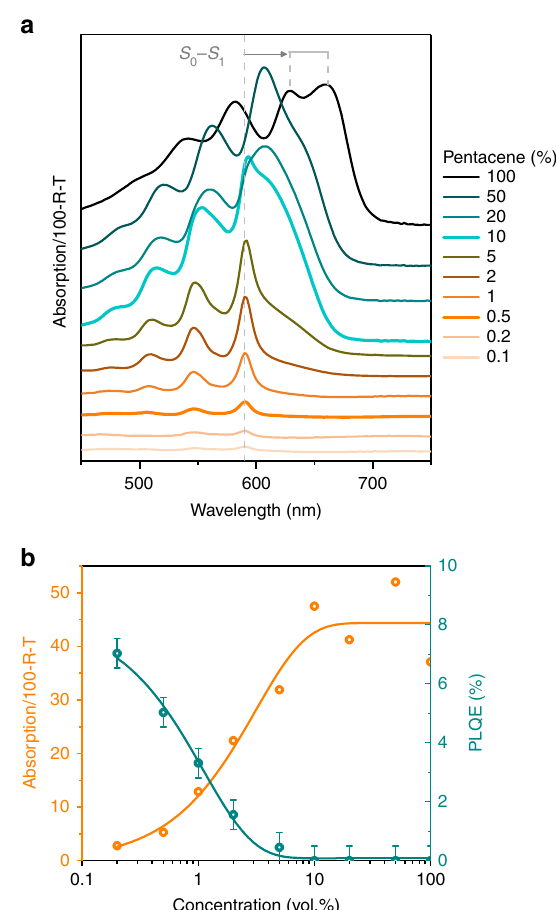
Fig. 3 Optical spectroscopy of the pentacene doped micron fi lms. a Absorption spectra (offset for clarity) as a function of pentacene concentration, with re fl ection and transmission subtracted from incident intensity (100-R-T), thus accounting for scattering. Below 2% pentacene, the single molecule spectra is seen with the S 0 − S 1 transition at 590 nm, while the Davydov split peak gradually appears above this concentration. A noticeable red-shift is also observed at higher concentrations. b The anti- correlation with pentacene concentration of absorption at 590 nm and photoluminescence quantum ef fi ciency (PLQE) measured at 590 nm excitation, including a 0.5% error due to instrument resolution. Trend lines are a guide to the eye. Above 10% pentacene, peak shifts affect the extracted value, whilst PLQE becomes